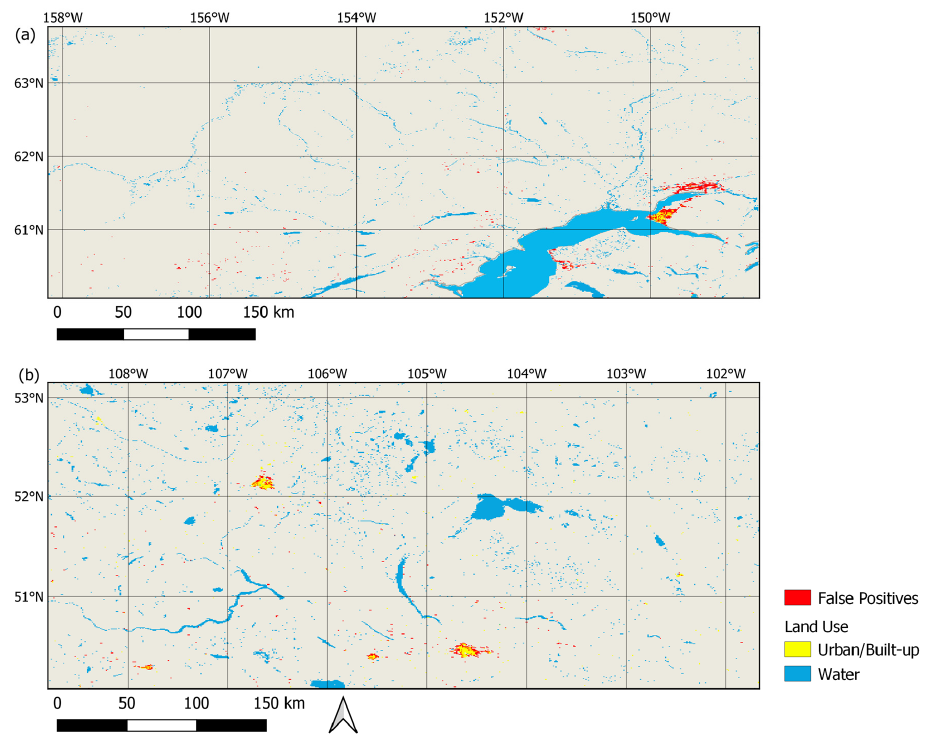
Figure 4. False positive values and urban/built-up areas in Alaska ( a ) and Saskatchewan ( b ) case